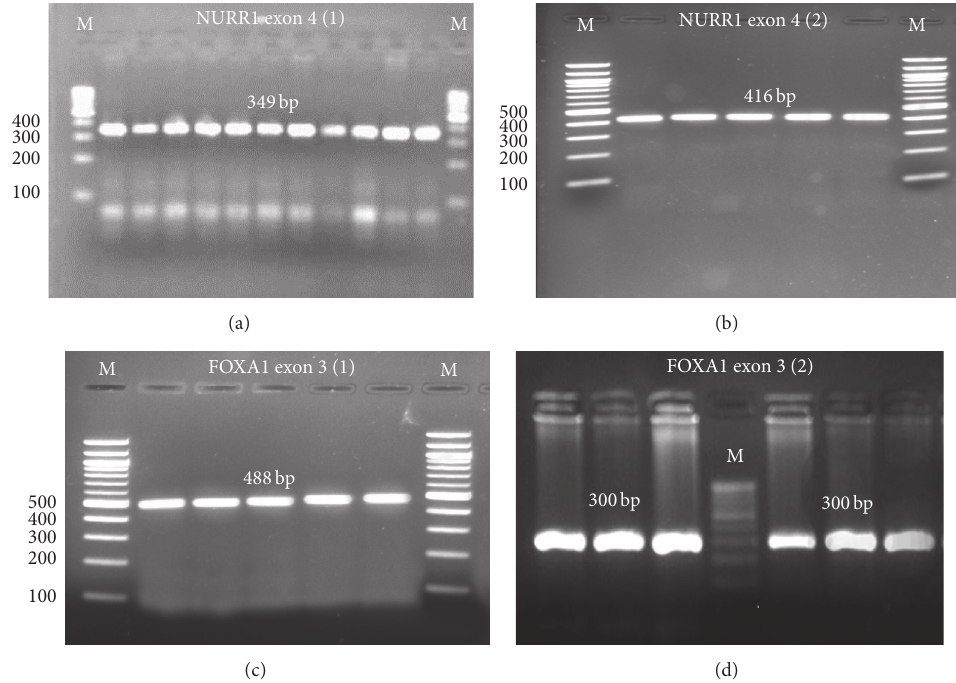
Figure 3: PCR amplification for exon 4 of the NURR1 gene (a-b) and exon 3 of the FOXA1 gene (c-d). The exons were divided into two reactions: 1 and 2, respectively.